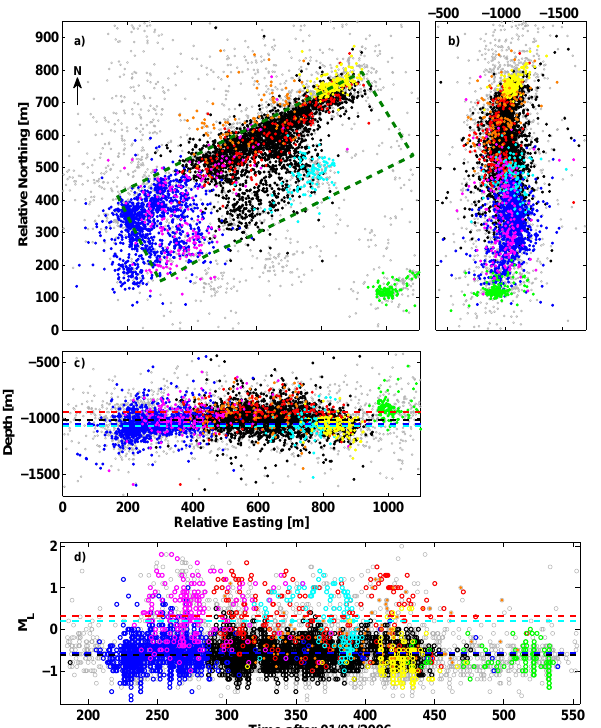
Fig. 7. Result of the visual cluster extraction (absolute event lo- cations). Colour coded are the eight largest clusters found by visual inspection of the sorted network SM in (a) map view, (b) N–S depth section and (c) E–W depth section. (d) Magnitude over time plot of the events. In all figures the grey circles indicate the events in the catalogue not belonging to the eight largest clusters. Broken line in (c) indicates the mean depth of the respective cluster. Broken line in (d) indicates the mean magnitude of the respective cluster. For clarity only the mean values of the four largest clusters are depicted in (c) and (d) . Note the exaggeration of the N–S and E–W axes in (b) and (c) , respectively, with respect to the depth axis.